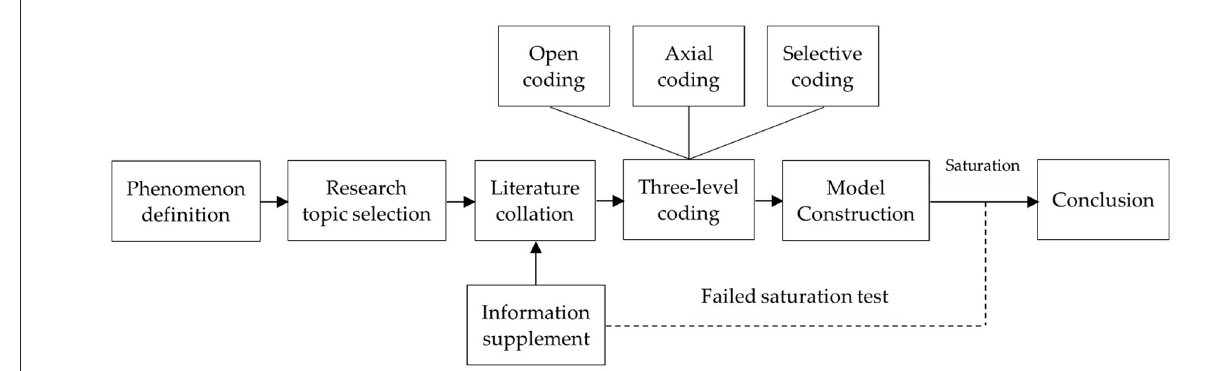
FIGURE1 Research process based on grounded theory.